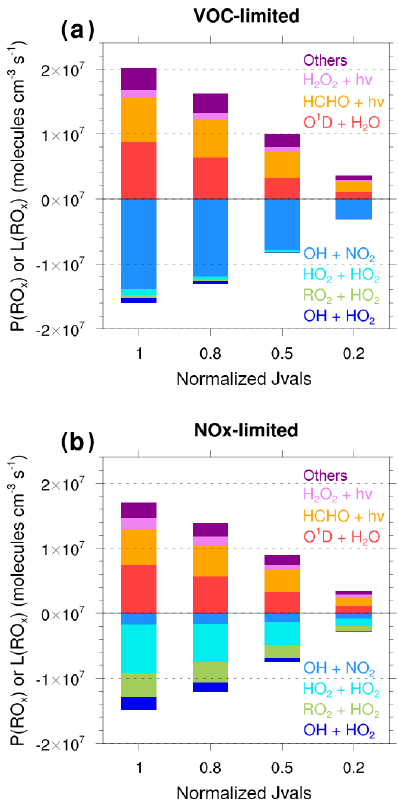
Figure 9. Results of box modeling for production and loss rates of RO x ( = OH + HO 2 + RO 2 ) radicals. “Others” in the legend in- dicates the photolysis of VOCs and reactions between alkenes and O 3 . The value of 1 of normalized Jvals on the x axis indicates the photolysis rates for clear-sky